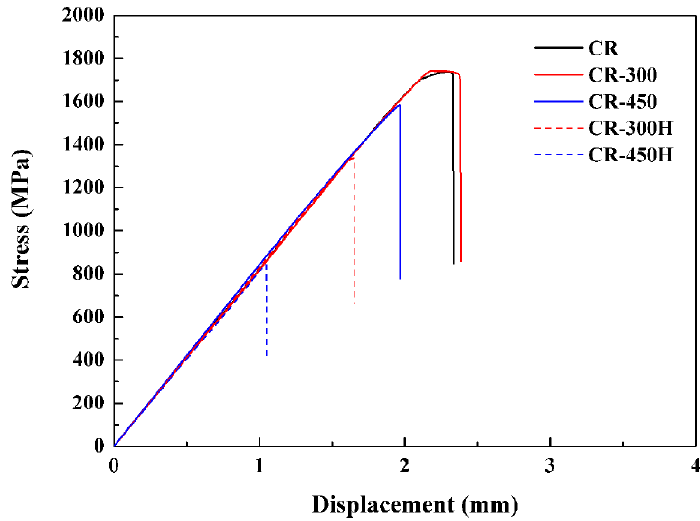
Figure 3. Notched tensile tests of non-hydrogen-charged (solid lines) and hydrogen-charged (dash lines) specimens.